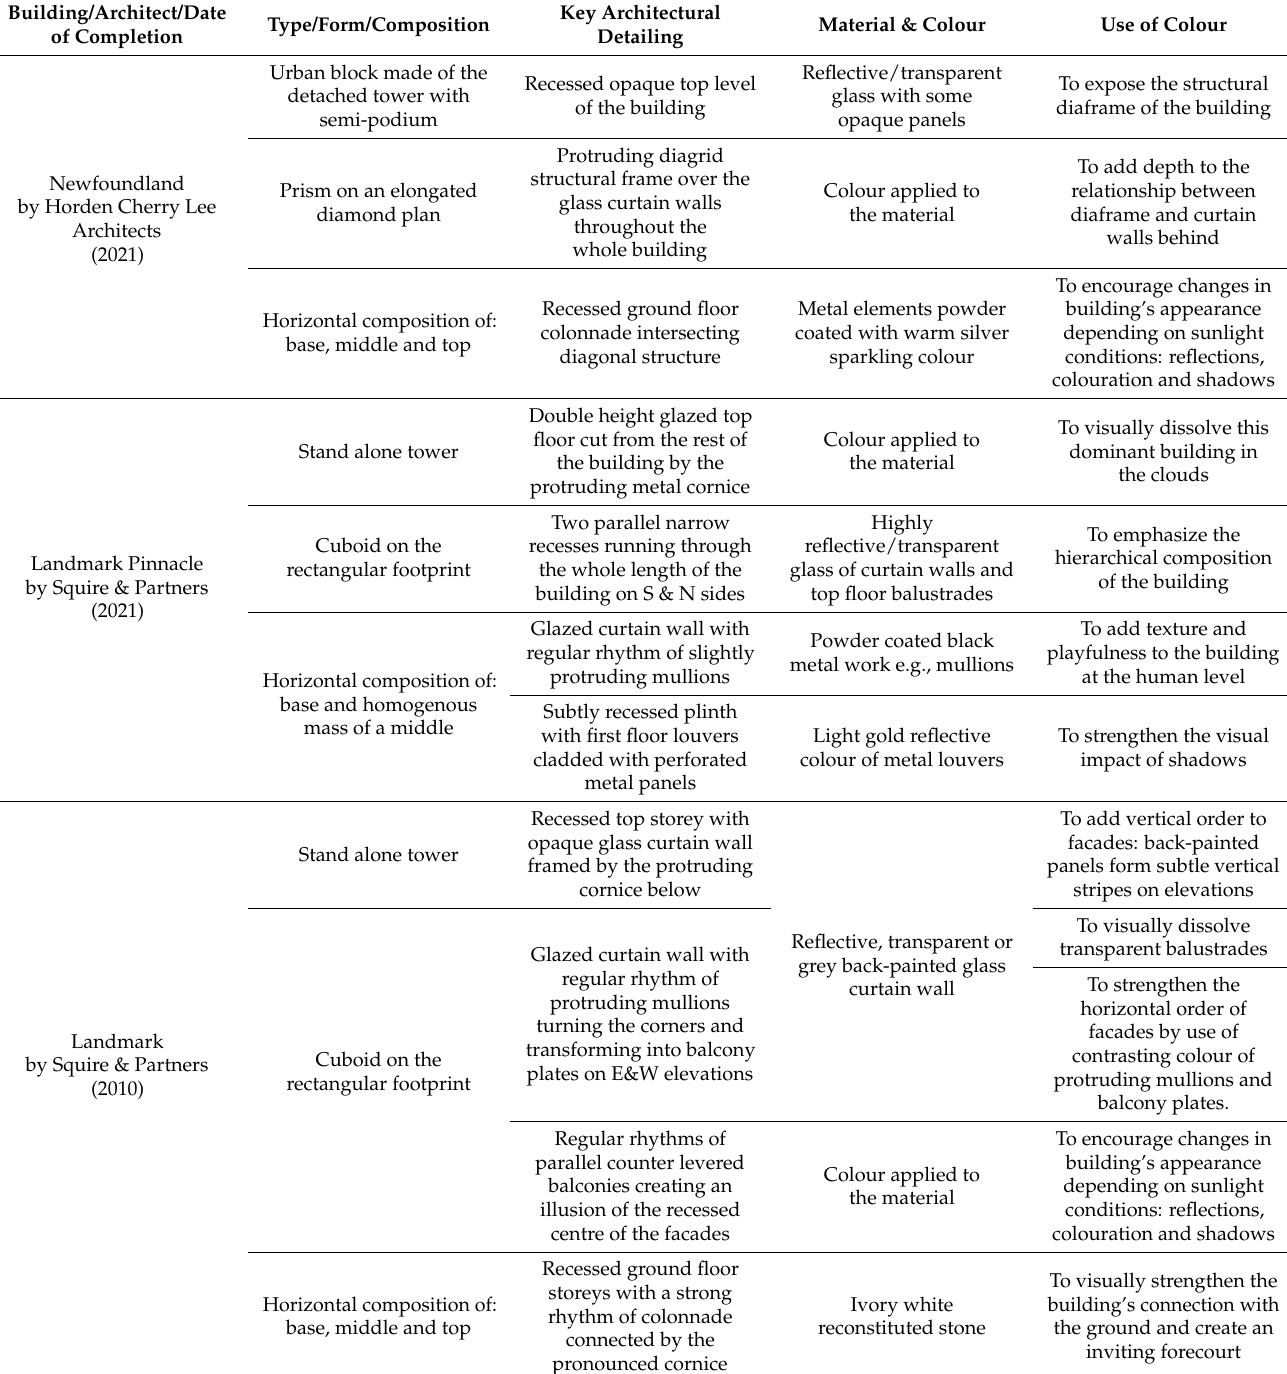
Table A4. Use of colour in residential tall buildings, the second phase of the regeneration on the Isle of